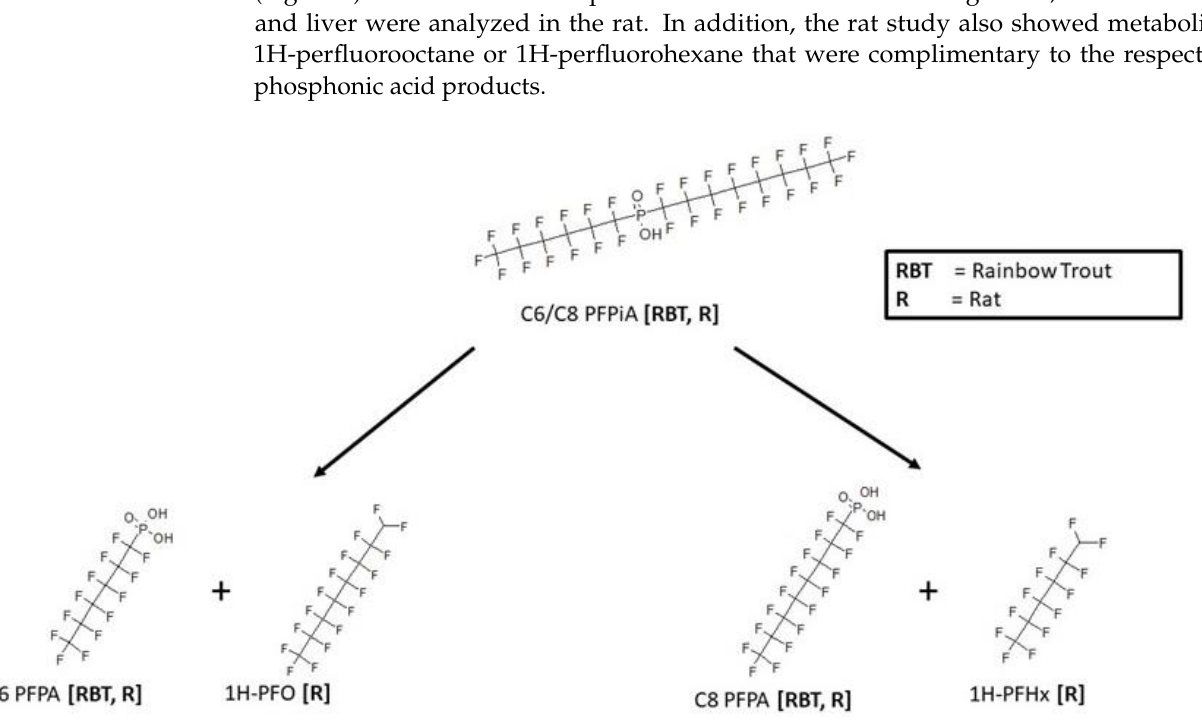
Figure 5. Highlight Treatment Group function for the in vivo study of 8:2 Fluorotelomer Acrylate (8:2 FTAc) in rainbow trout. Colored boxes around metabolites in the metabolic map are correlated to the respective treatment groups, which are bile, blood, feces, kidney, and liver, in this case.